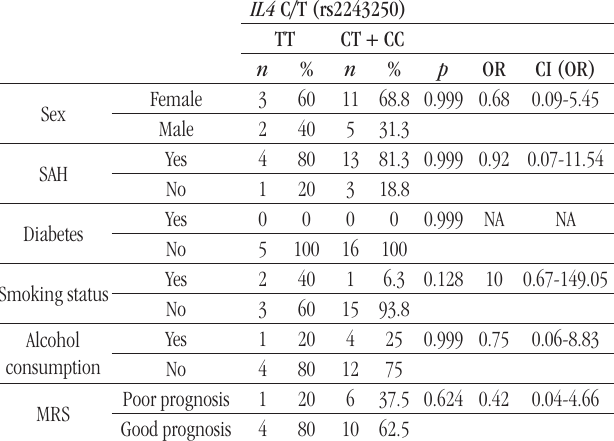
table – Association between IL4 -589 (C/T) rs2243250 polymorphism genotypes and clinical aspects in the